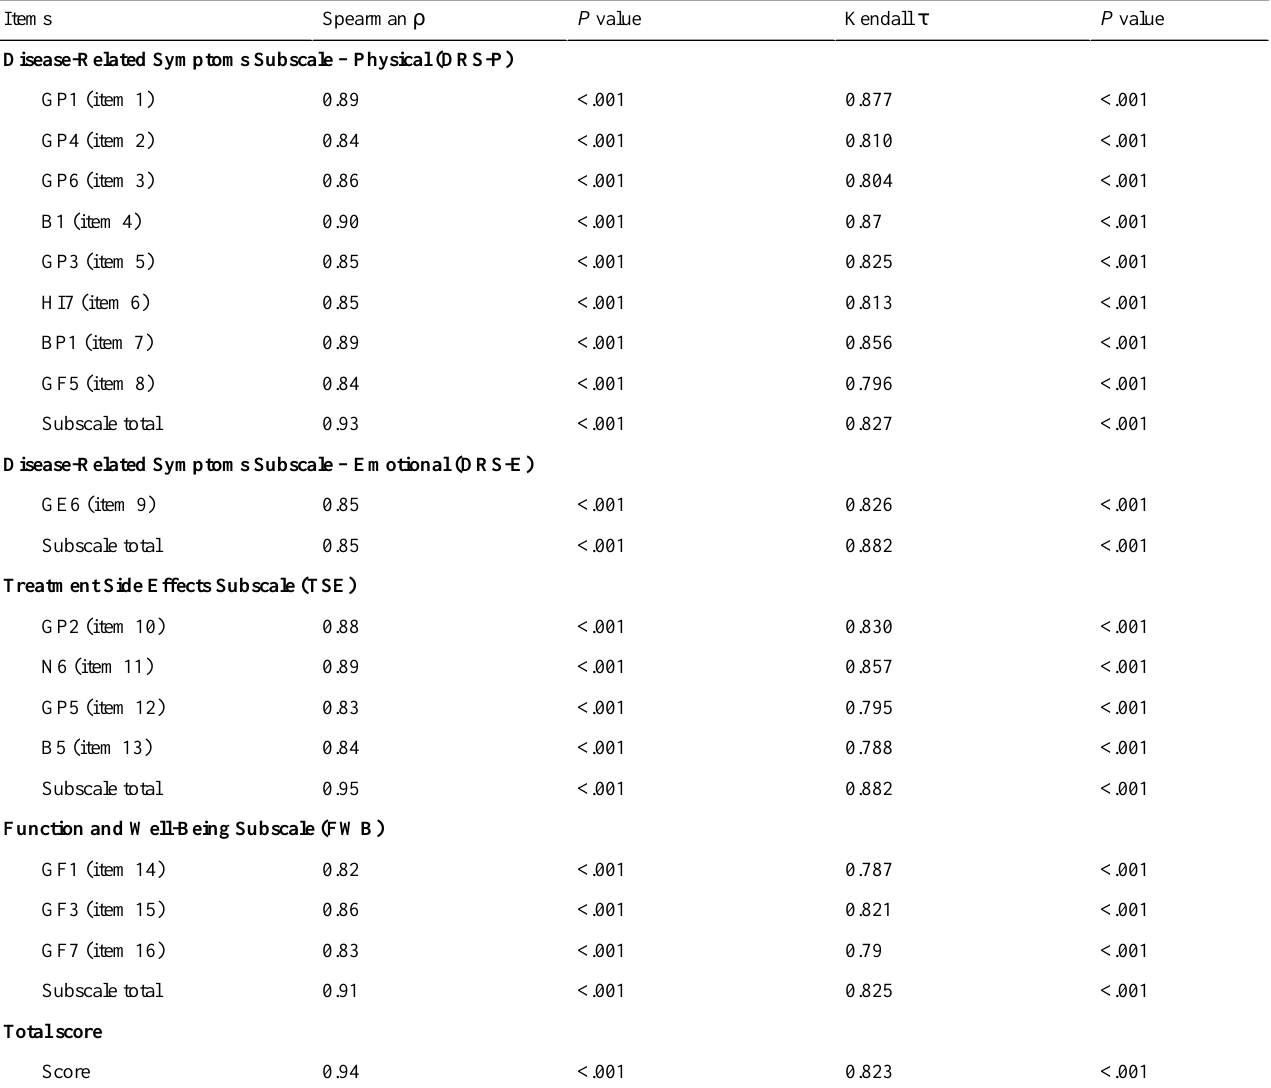
P valueKendall τ P valueSpearman ρ Items